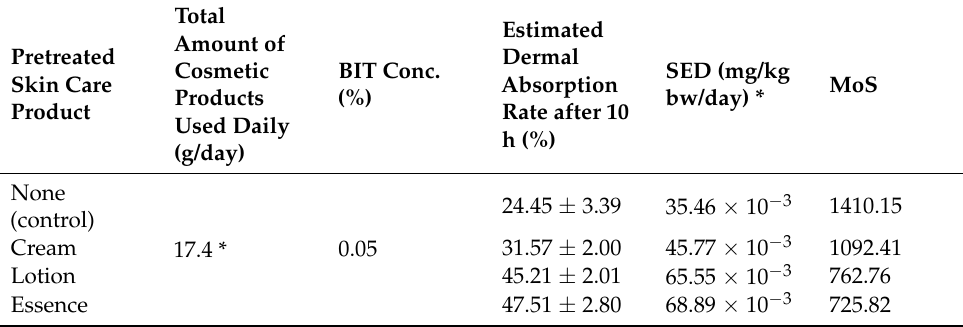
Table 5. Risk assessment of BIT in the presence of skincare